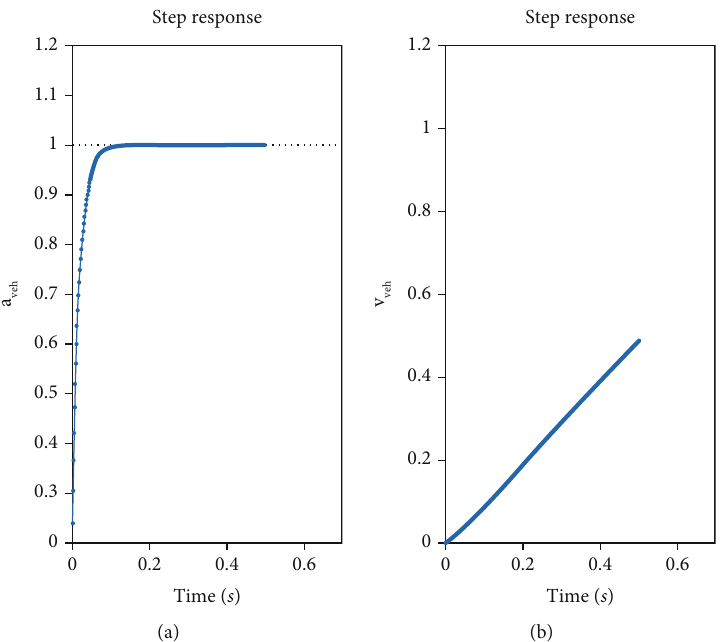
Figure 12: Vehicle acceleration (a) and speed (b) responses, respectively, in PID-CHR (1).